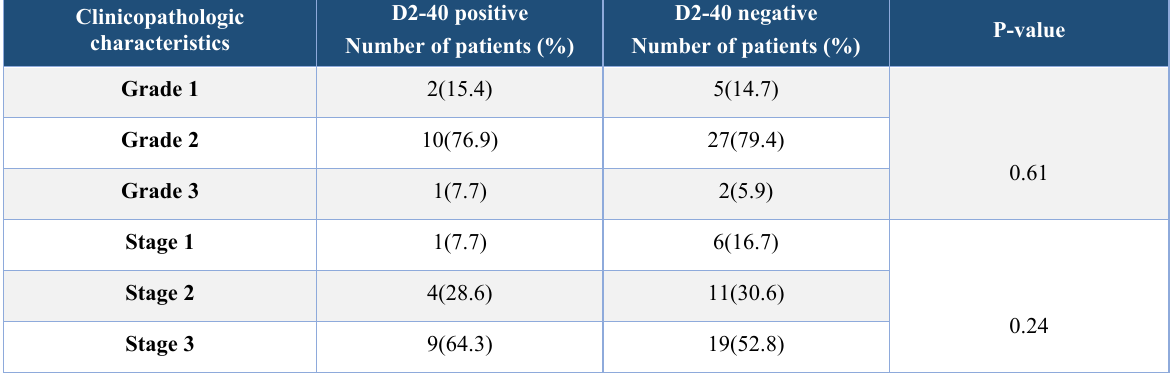
Table 3. Correlation between clinicopathological characteristics and D2-40 staining